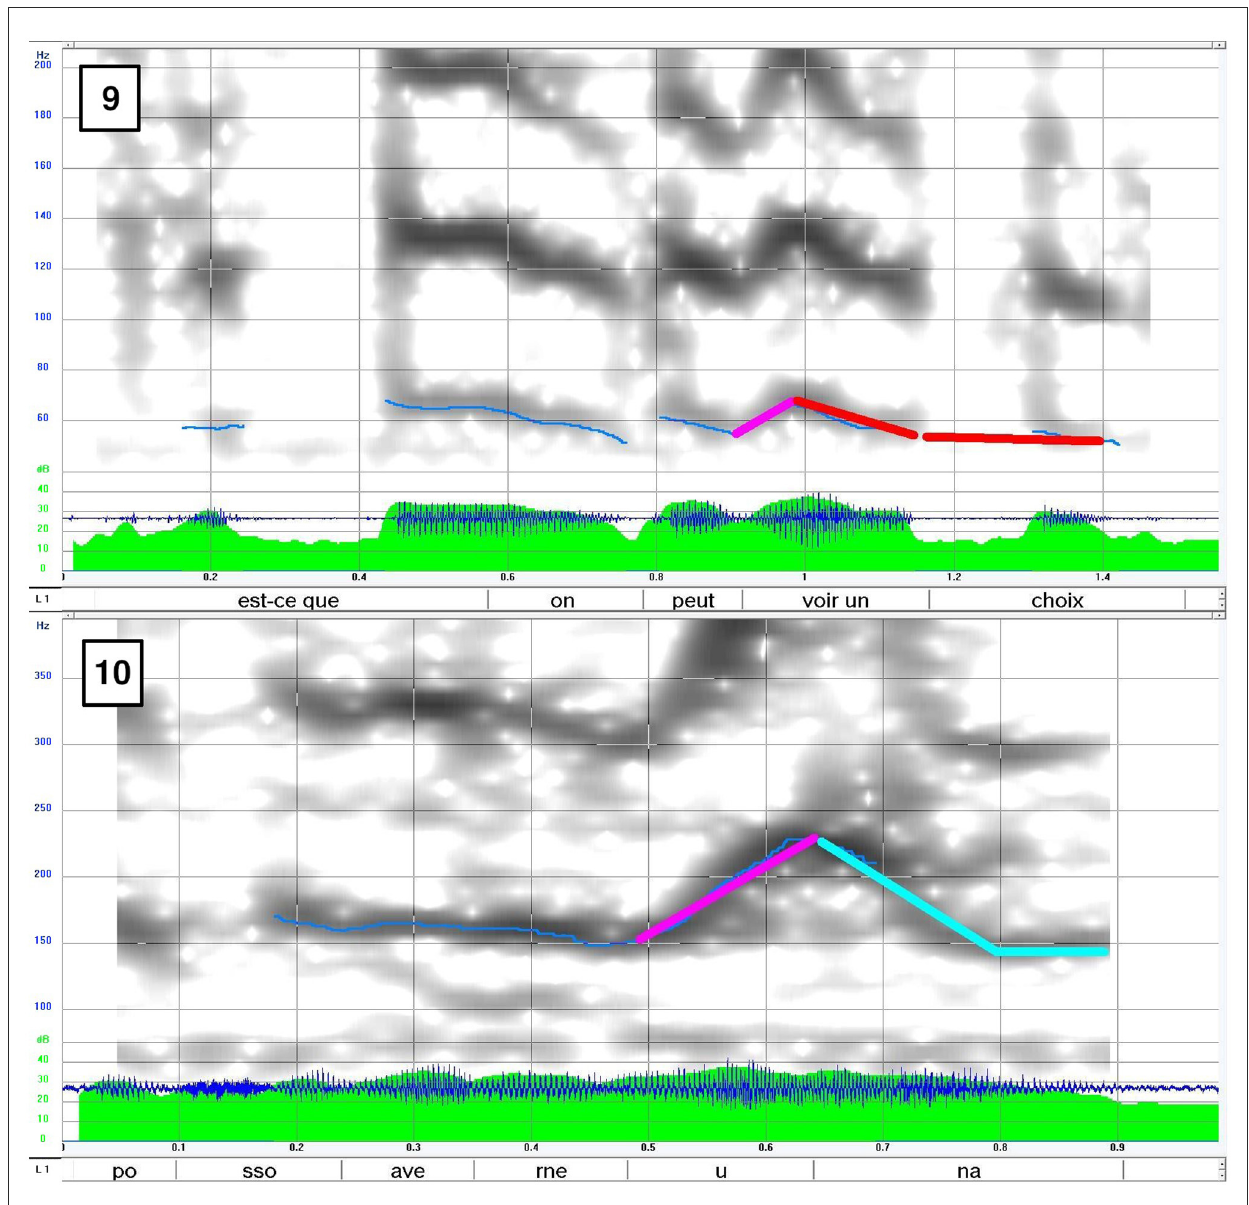
FIGURE7 Prototypic contours of Challenging questions in French and Italian (“Injunctive Pattern” 9; 10) (Supplementary Audio